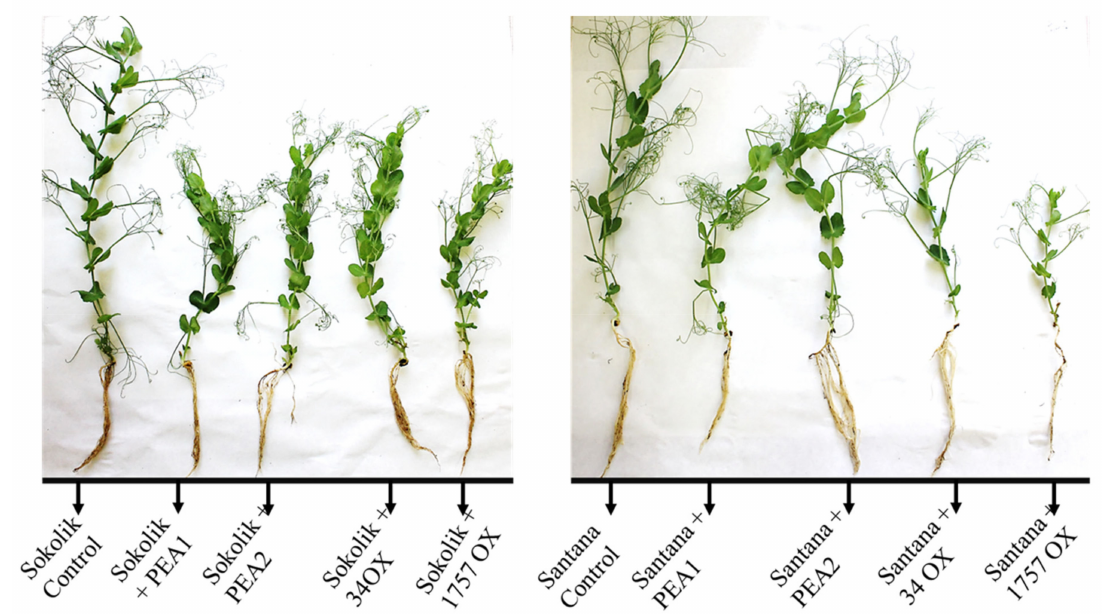
Figure 4. Comparison of the growth of pea plants upon infection (13th